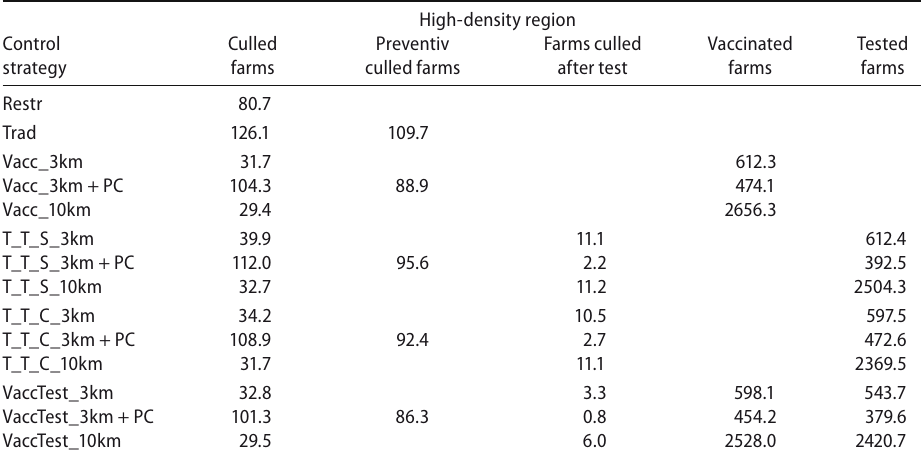
Table 5 Number of culled, thereof preventive culled respectively culled after a positive PCR result, vaccinated and tested farms for the high-density